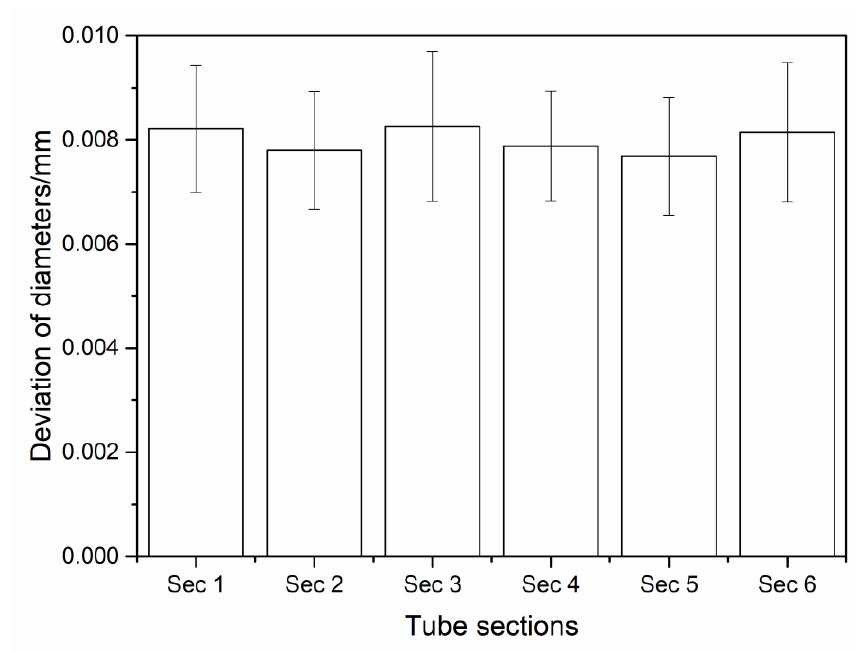
Figure 15. Deviation of diameters in the precision validation experiment. Table 1. Deviation of angles in the precision validation experiment.